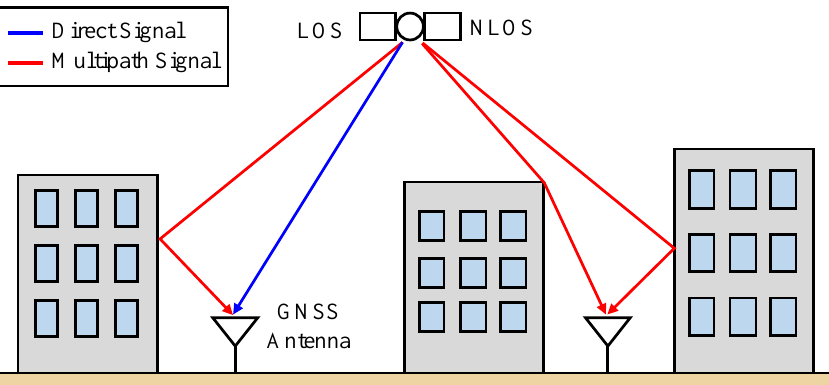
Figure 1. Comparison of line-of-sight (LOS) and non-LOS (NLOS) multipath signals. If a global navigation satellite system (GNSS) receiver receives reflected or diffracted signals from an “invisible” satellite behind a building, a large positioning error will